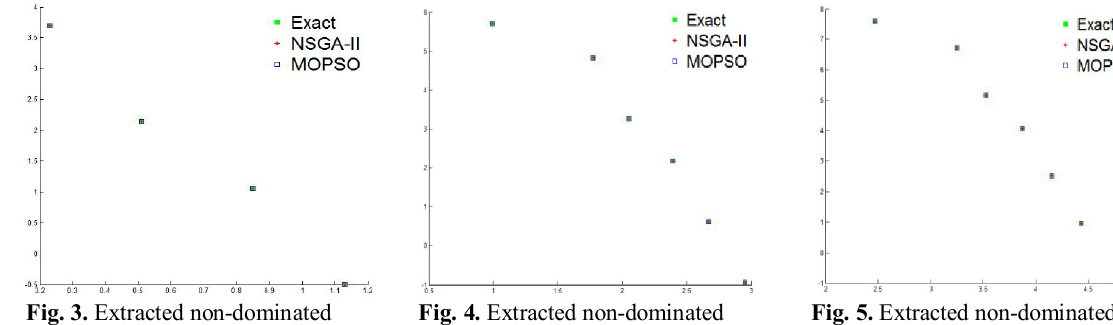
Fig. 4. Extracted non-dominated solutions by different approaches for permutation problem with 5 alternatives